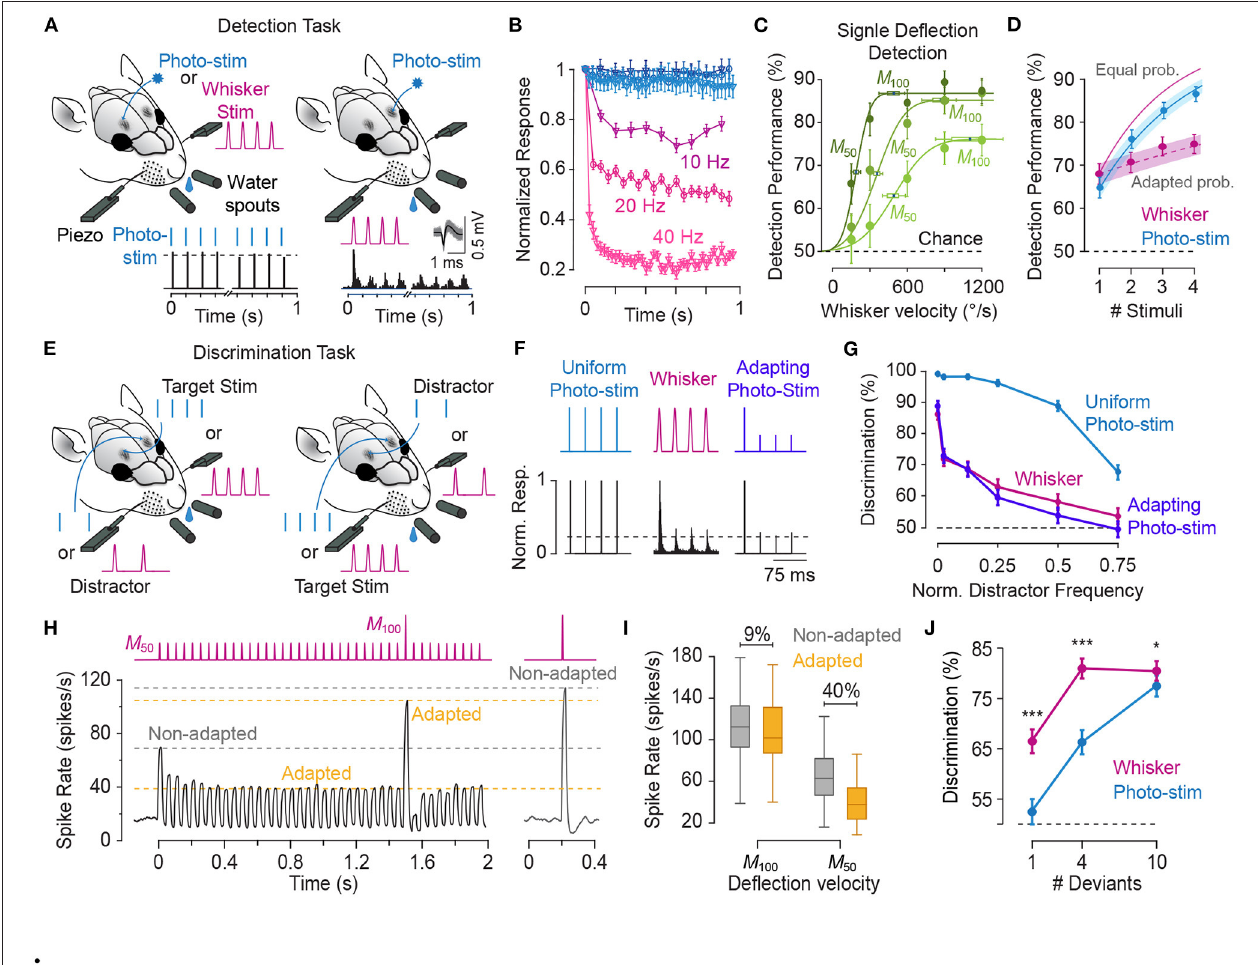
FIGURE 9 | Circumventing cortical adaptation enhances detection and frequency discrimination, while adaptation improves deviant detection. (A) Detection task: in a 2-alternative choice task, rats were trained to detect stimulus that applied to either the left or the right C1 whisker or its barrel column. A reward was given if the animal responded correctly by licking at one of two water spouts on the side associated with the stimulus side. Whisker stimuli (red) consisted of individual or uniform sequences of pulses (single-cycle 120-Hz sine-wave). Photo-stimuli (blue) consisted of individual or sequence of 1-ms square-wave pulses. Insets show extracellular recording from two neurons to 40-Hz photo-stimulation (left) and stimulation of the principal whisker (right). PSTHs with spike rates normalised to the initial response. (B) Normalised response to whisker pulses (shades of red, 33 neurons) and photo-stimulation (shades of blue, 15 neurons) at 5, 10, 20, and 40 Hz frequencies (darker corresponds to higher frequencies) showing frequency-dependent adaptation to whisker stimulation and little adaptation to photo-stimulation. (C) Velocity-response curves for detection of single-pulse whisker deflections for 3 rats. M 50 and M 100 correspond to the turning point and the asymptote of the cumulative Gaussian function fitted to each curve, respectively. (D) Circles represent detection performances for sequences of 1–4 stimuli (with 25 ms inter-pulse interval) at M 50 . Detection of single whisker stimulus was 67.9%. However, detection rate increased by an average of 2.3 ± 0.93 % for every additional stimulus in the sequence. This is lower than the prediction that every stimulus had an equal perceptual detectability (equal probability model, solid curves). When adaptation was considered by reducing the detection probability of subsequent pulses according to observed neuronal adaptation in (B) (adapted probability model, dashed line), the predicted curve matched the behavioural detection performance. In contrast with whisker stimulation, detection performance of direct cortical photo-stimulation (in blue) was well-explained by equal detection probability of individual pulses (solid blue curve). This indicates that non-adaptive neural activation (as in B ) results in uniform perceptual weight of individual pulses in a sequence. (E) Frequency discrimination task; as in (A) , but the animals were trained to discriminate between a target stimulus (1-s long sequence of stimuli at 20 or 40 Hz) and a distractor with a lower frequency. (F) Three stimuli used in the discrimination task, with the corresponding normalised PSTHs (lower panels). Dashed line represents the adaptation level to whisker stimulus at 40 Hz. The whisker stimuli and uniform photo-stimulation pulses were set at M 100 level. for the adapting photo-stimulation, the irradiation level of the initial pulse was set to M 100 , while the irradiation of subsequent pulses was reduced to that matching adaptation to whisker stimulation. (G) Frequency discrimination performances plotted against the frequency of distractor normalised to that of the target stimuli. Comparing discrimination performances for adaptation-free uniform photo-stimulation (blue) to whisker stimulation (red) reveals that adaptation reduces frequency discrimination performances. Adapting photo-stimulation (magenta) mimics whisker stimulation, resulting in reduced frequency discrimination performances. (H) Adaptation facilitates detection of deviant stimuli. The black trace shows average neural responses ( n = 33) to a 2-s long 20-Hz whisker stimulation sequence (at the mean M 50 velocity of 350 ◦ /s) with a single deviant (at M 100 , 850 ◦ /s). Response amplitude to subsequent pulses was decreased by 40% relative to the initial pulse, whereas deviant response amplitude remained close to non-adapted single-pulse response. (I) As in (H) , but using whisker-box plot. The box shows